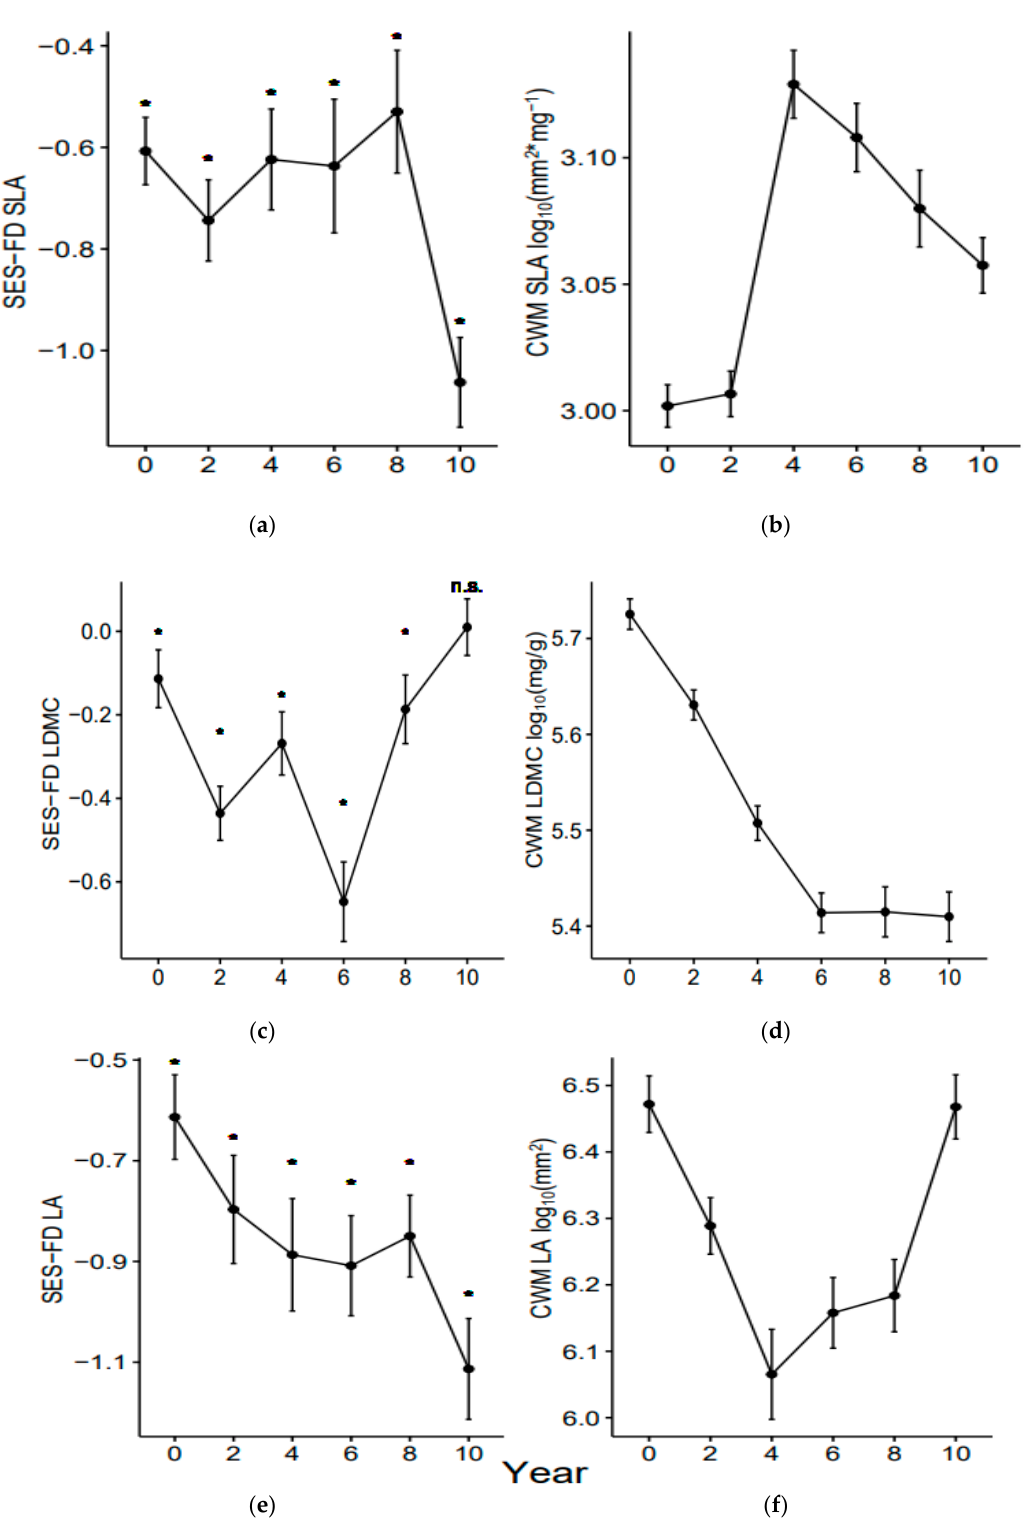
Figure 3. Trends of standardized effect size of functional diversity (SES-FD) and community weighted means (CWMs) (mean ± s.e.) for ( a , b ) specific leaf area (SLA), ( c , d ) leaf dry matter content (LDMC), and ( e , f ) leaf area (LA) under twice-a-year mowing. Year 0 (before treatment) refers to 2010; years 2, 4, 6, 8, and 10 correspond to 2012, 2014, 2016, 2018, and 2020. The asterisk ( * ) and n.s. indicate whether the distribution of SES-FD is significantly or not significantly different from zero after a one-sample two-tailed t -test ( p < 0.05).